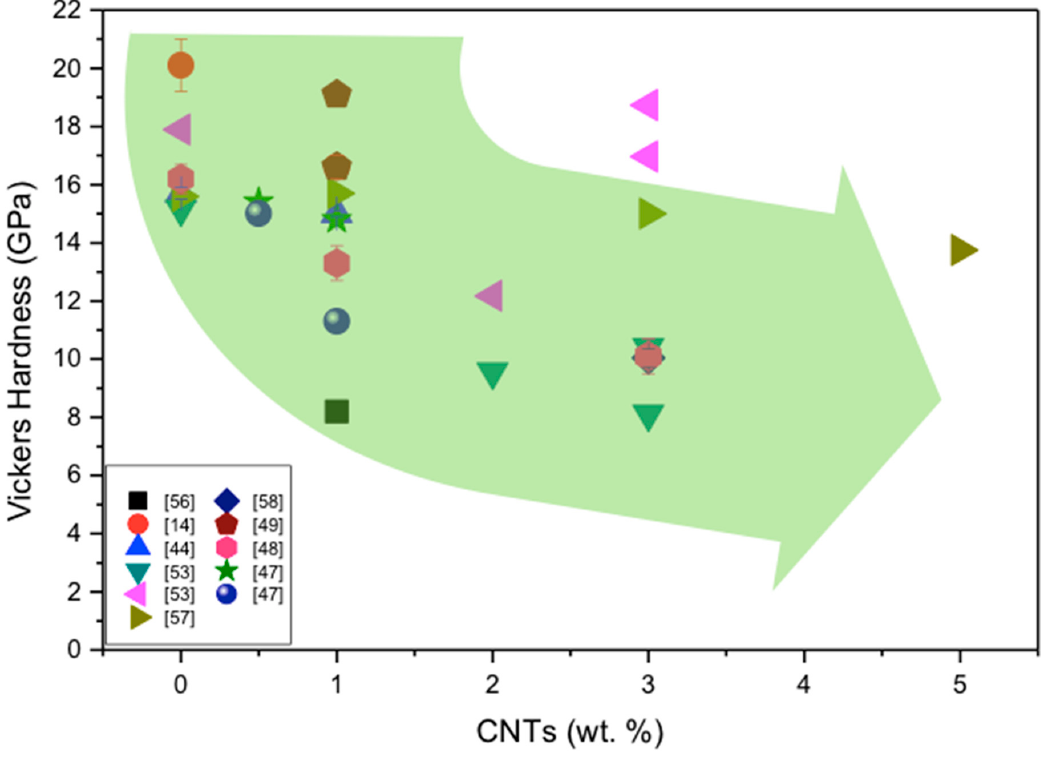
Figure 6. Vickers micro-hardness of CNT-reinforced silicon nitride composites according to the results of different investigations. The green highlighted arrow indicates the decreasing tendency of Vickers hardness of Si 3 N 4 composites with increasing CNTs content. The details concerning the processing route of the preparation of investigated composites are illustrated in Table 2.